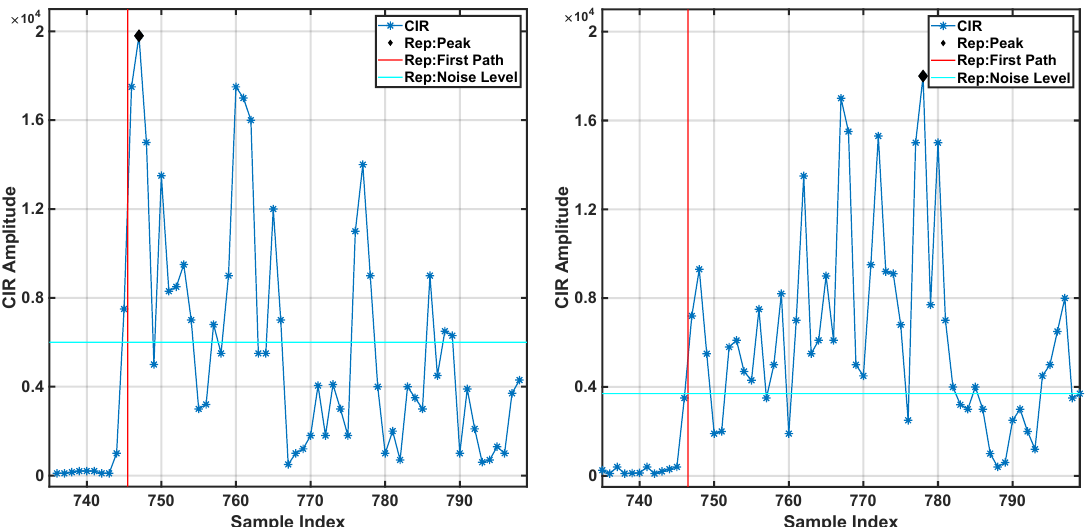
Figure 4. CIR example of Line of Sight ( left ) and No Line of Sight ( right )